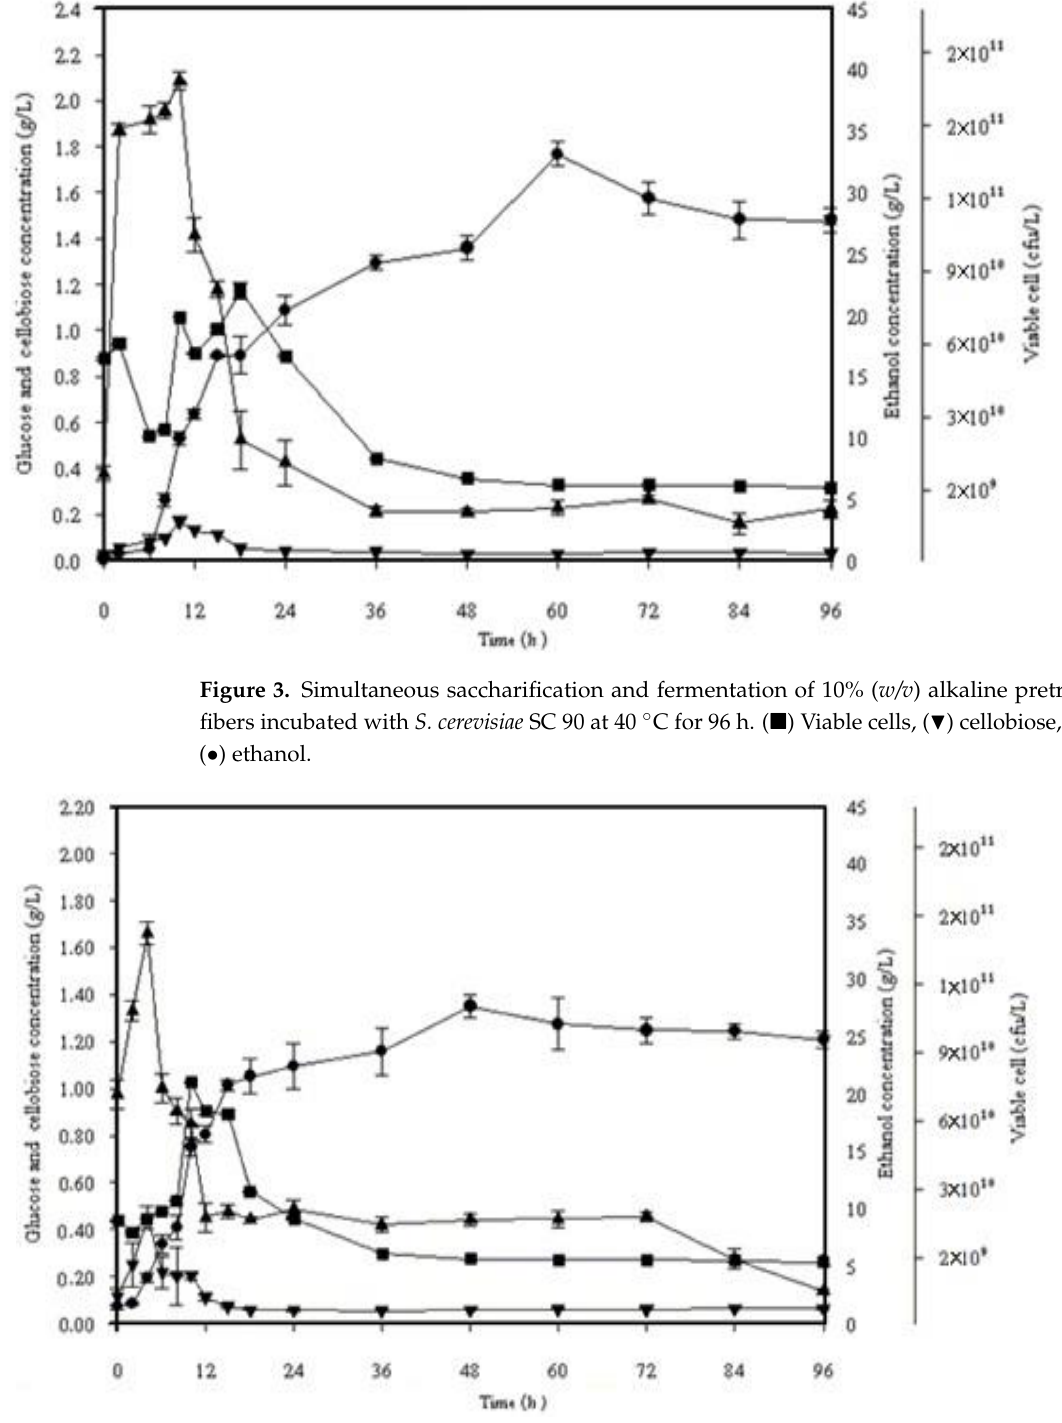
Figure 4. Simultaneous saccharification and fermentation of 10% ( w/v ) alkaline pretreated frond fibers incubated with S. cerevisiae SC 90 at 45 °C for 96 h. ( ■ ) Viable cells, ( ▼ ) cellobiose, ( ▲ ) glucose, ( ● ) ethanol.